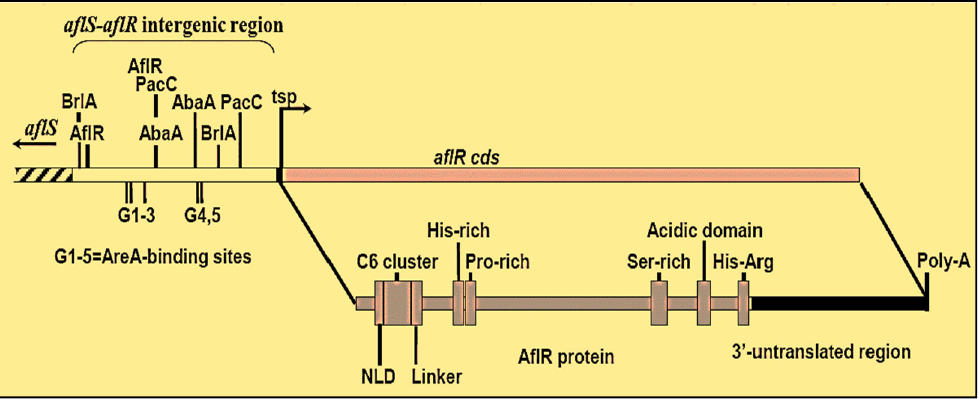
Figure 3. Genetic regulation of AF biosynthesis.